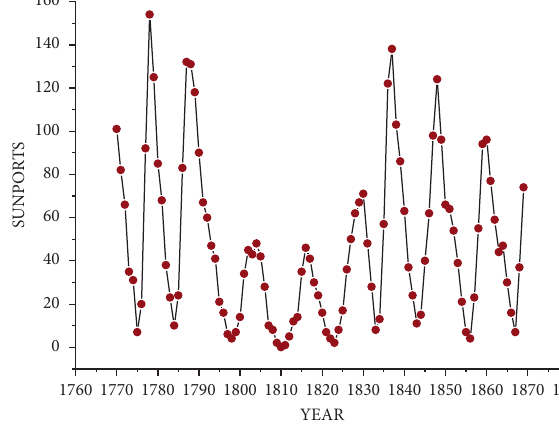
Figure 4: Trend of sunspot observations from 1770 to